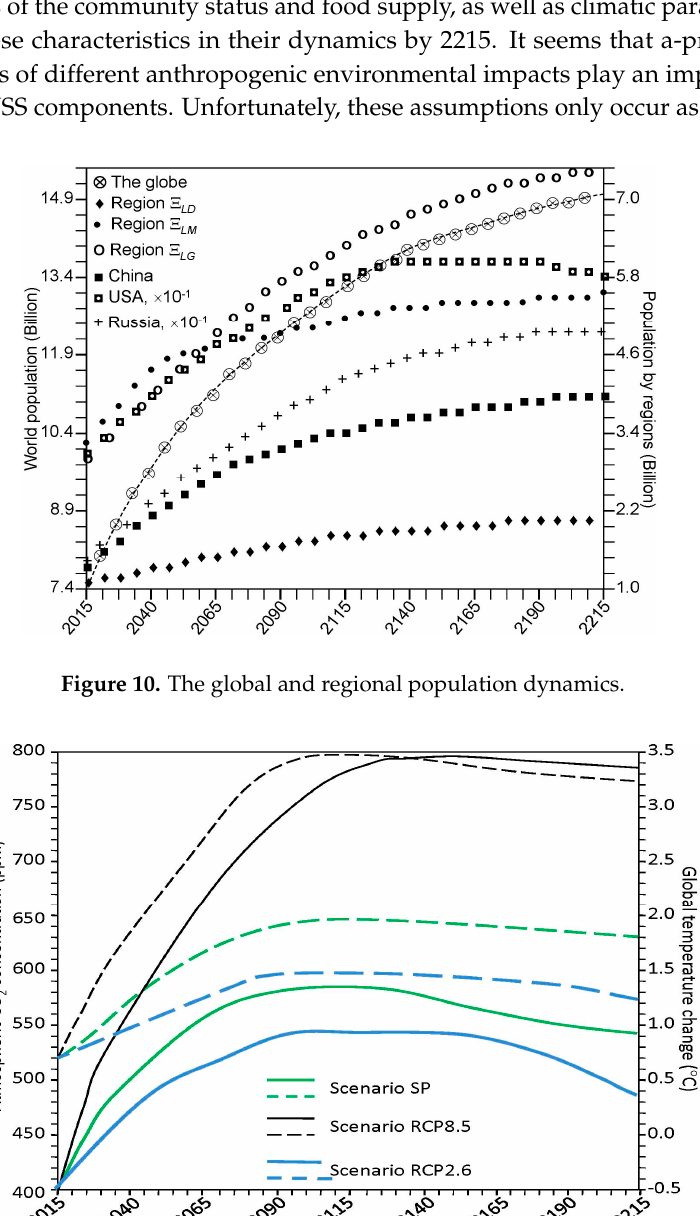
Figure 9. Survivability indicator depending on the GDP distribution by agriculture (solid lines) and industry (dashed lines). Numbers located on the right of the curves show the time periods for the investments: 1–25 years, 2–50 years, 3–75 years, and 4–100 years.